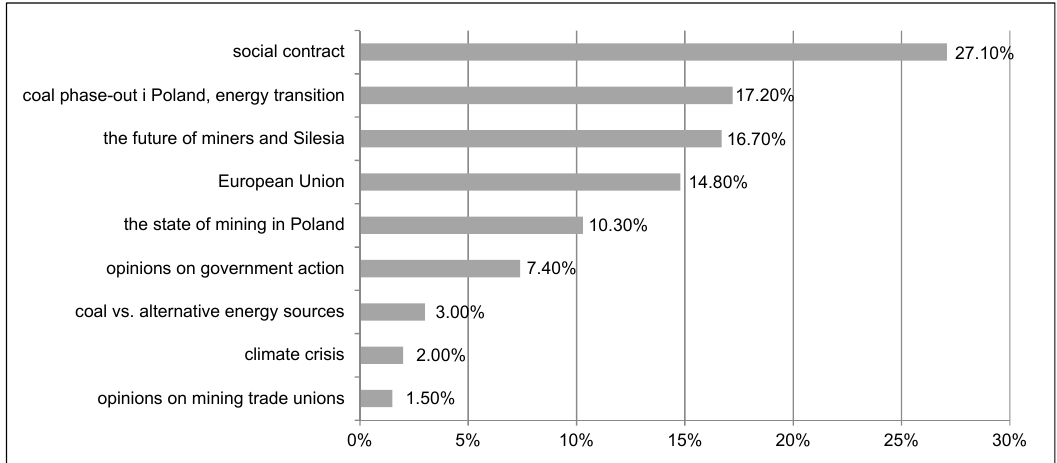
Figure 3. Presentation of the nine themes in the discourse . Source : author’s own compilation using MAXQDA.